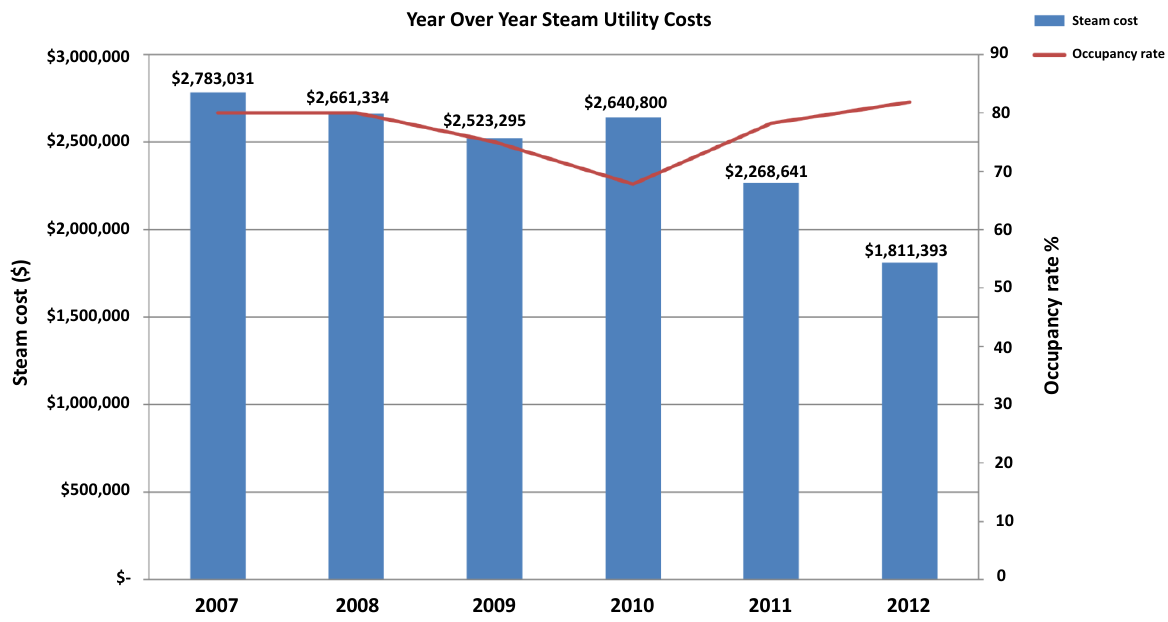
Figure 3. Empire State Building Performance Year 2. Reduction in ESB’s 2007 Baseline Steam Utility Costs during Performance Period (Graph by author; redrawn from